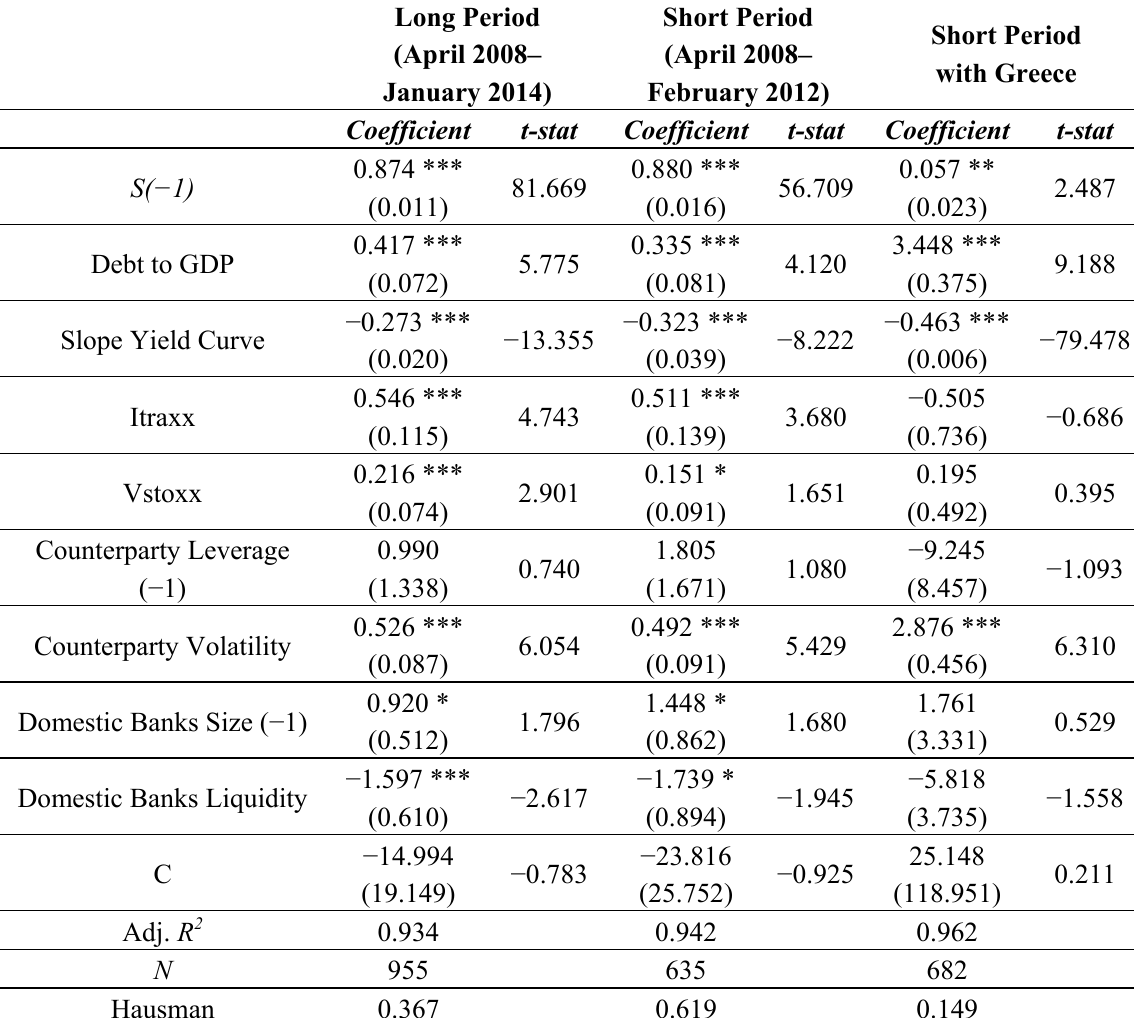
Table 5. Pooled Regression